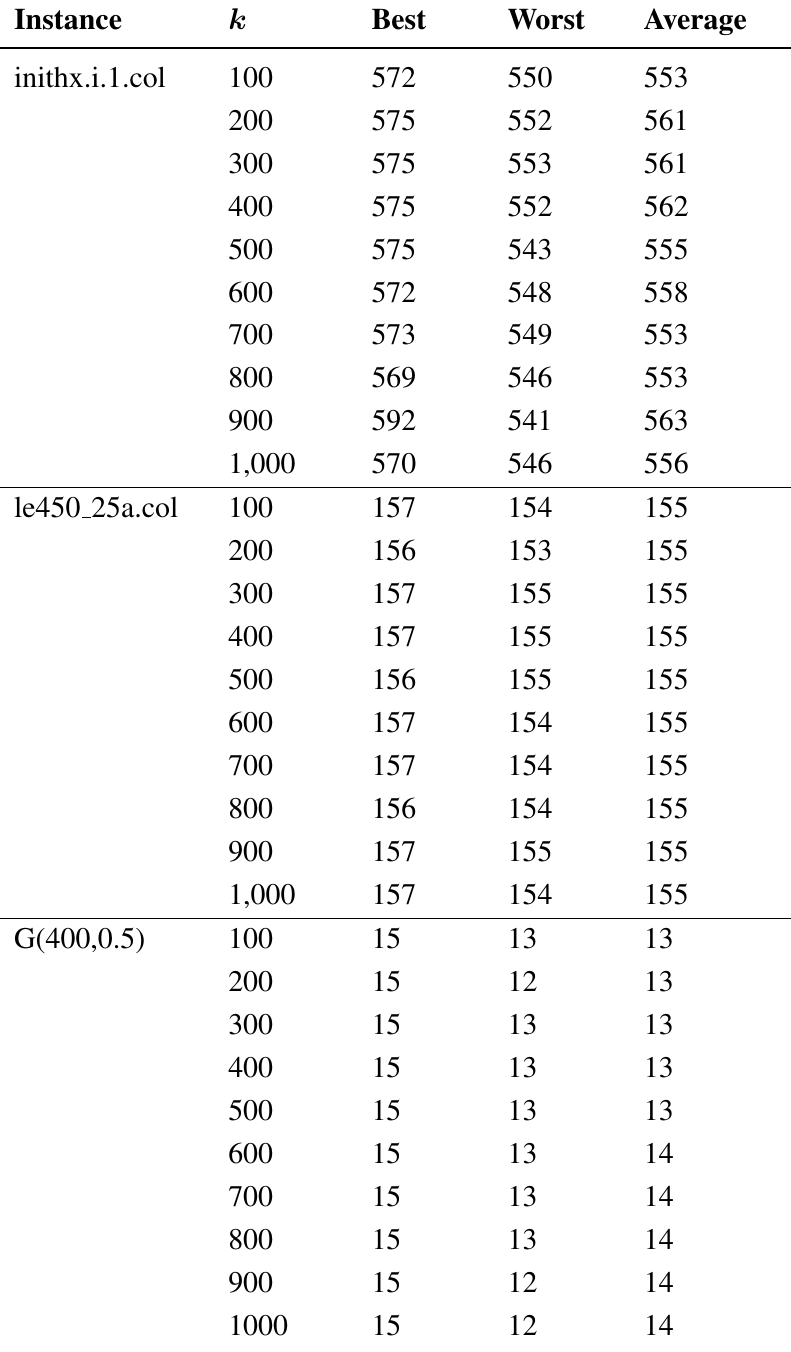
Table 2. Results with with different values of the parameter